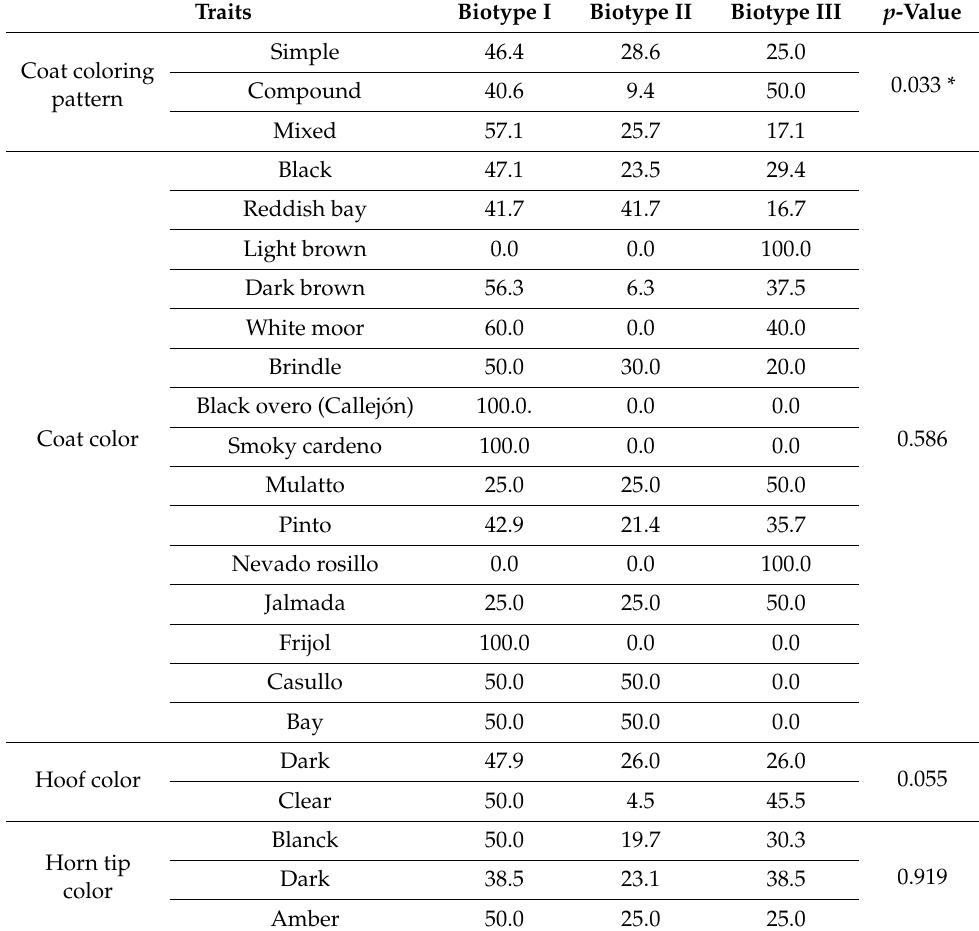
Table 2. Qualitative traits of Creole cow biotypes from Amazonas region, Peru (%) 1